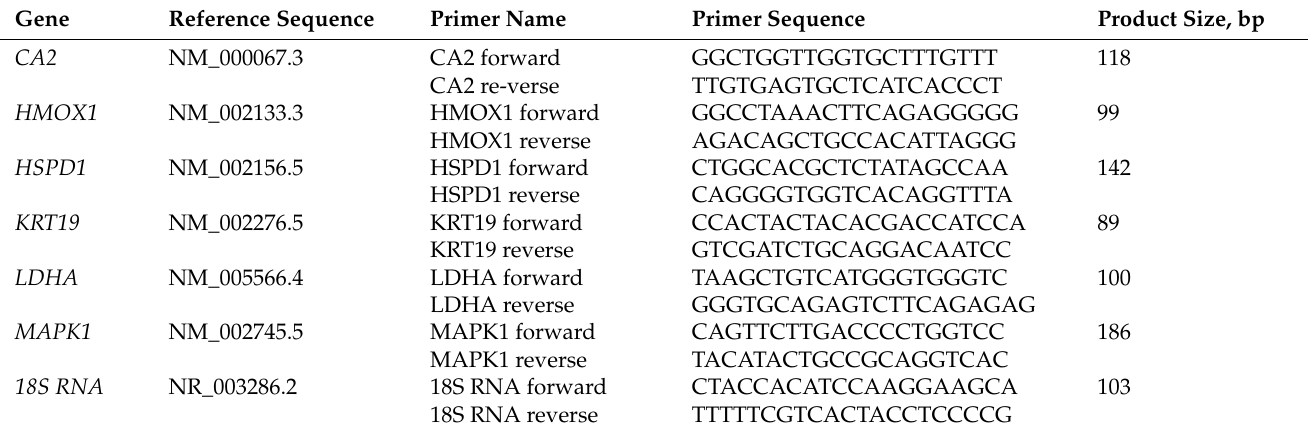
Table 2. Gene-specific primers used in the qPCR